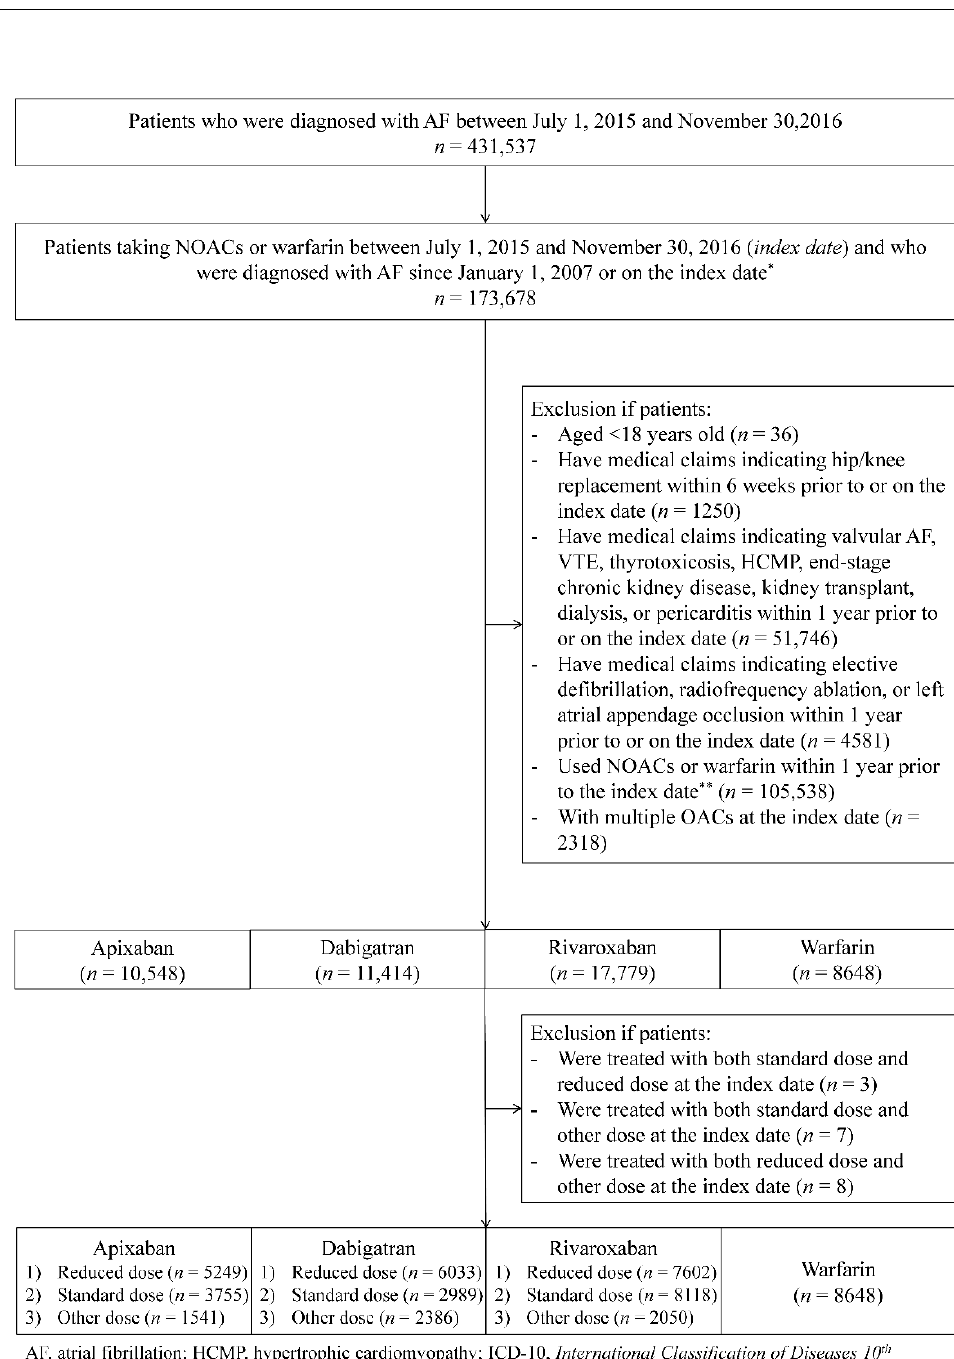
renal and liver function, stroke, bleeding, labile international normalized ratio, elderly, drugs or alcohol; H2RA, H 2 -recep- tor antagonists; PPI, proton pump inhibitors; R, reduced dose. 1 p values were not significant for all comparisons (R.Apix- aban vs. Warfarin; R.Dabigatran vs. Warfarin; R.Rivaroxaban vs. Warfarin). 2 Absolute standardized differences were not